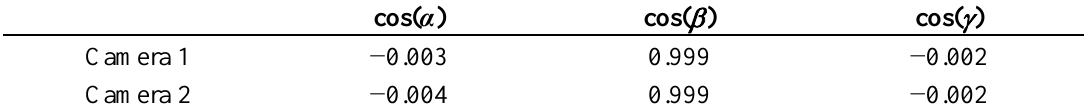
Table 4. MLS direction cosines obtained for each camera.